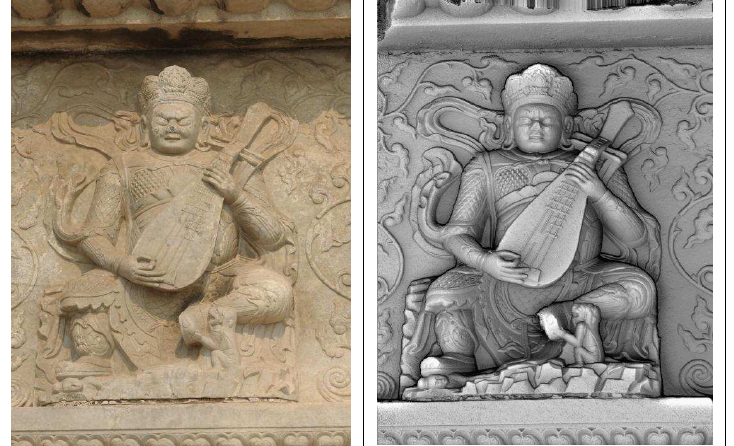
Figure 6. Gardian of Zhenjue